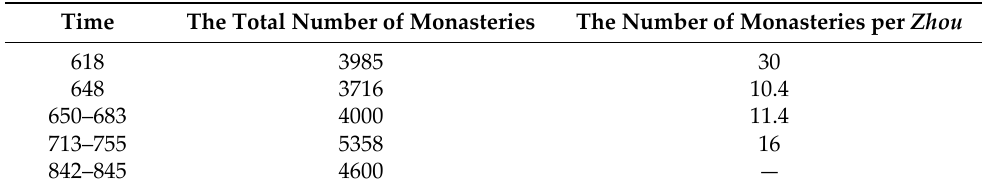
Table 1. The number of monasteries during the Sui and Tang